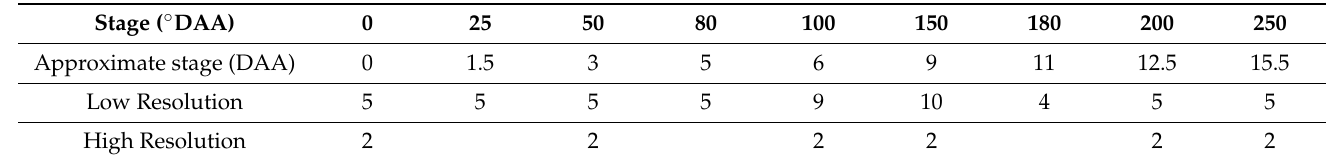
Table 1. Number of replicates for each development stage, expressed in thermal time after anthesis ( ◦ DAA) or in approximate number of days after anthesis